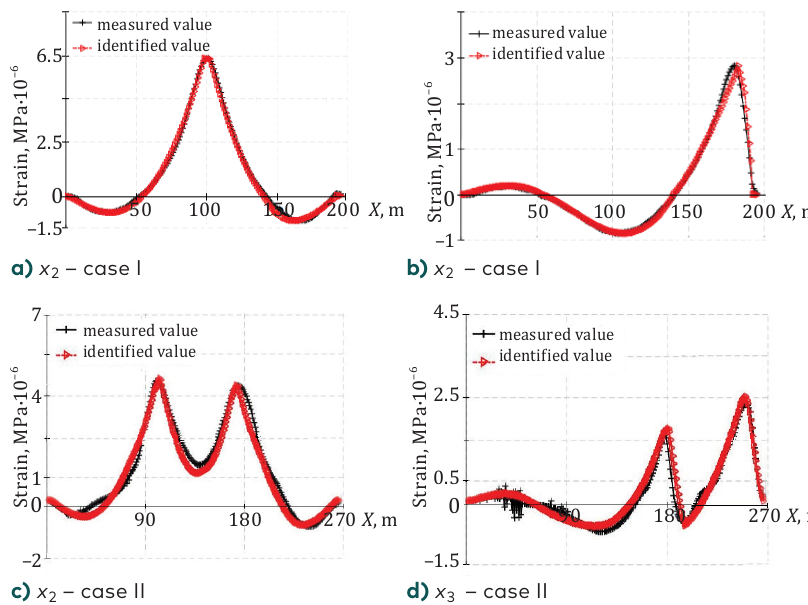
Figure 22. Estimated strain time history by the identified strain influence